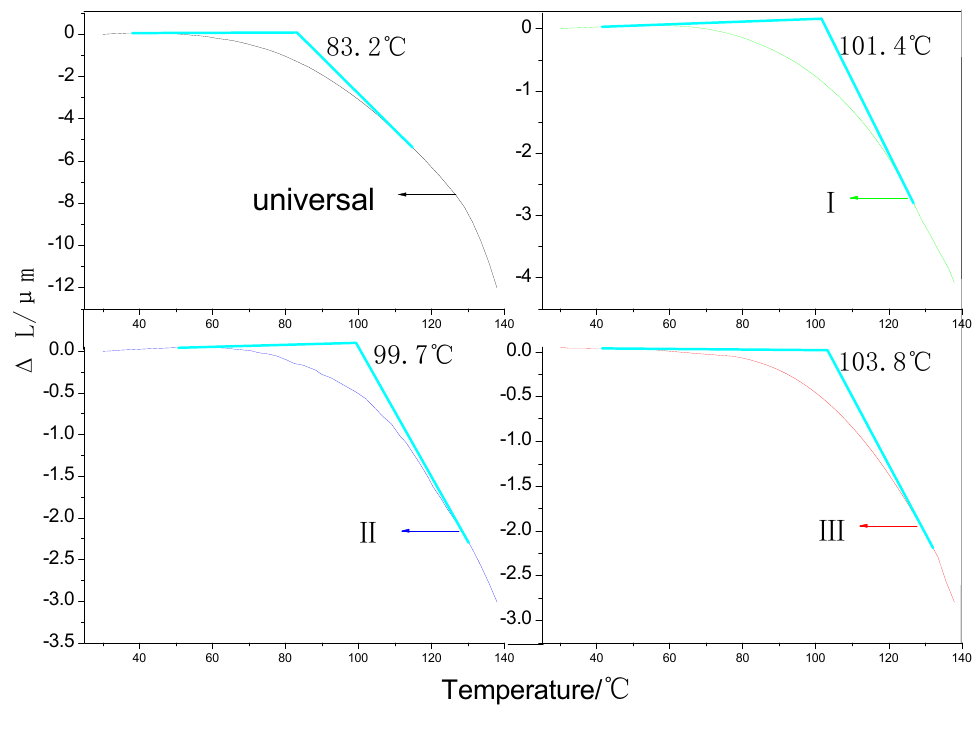
Figure 1. TMA curves of foam plastics.